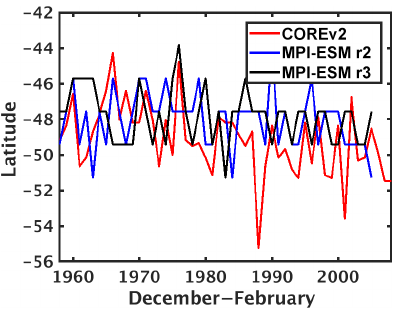
Figure 5. Meridional position of the maximum intensity of the westerlies in December–February derived from the COREv2 re- analysis and the MPI-ESM historical simulations r2 and r3.